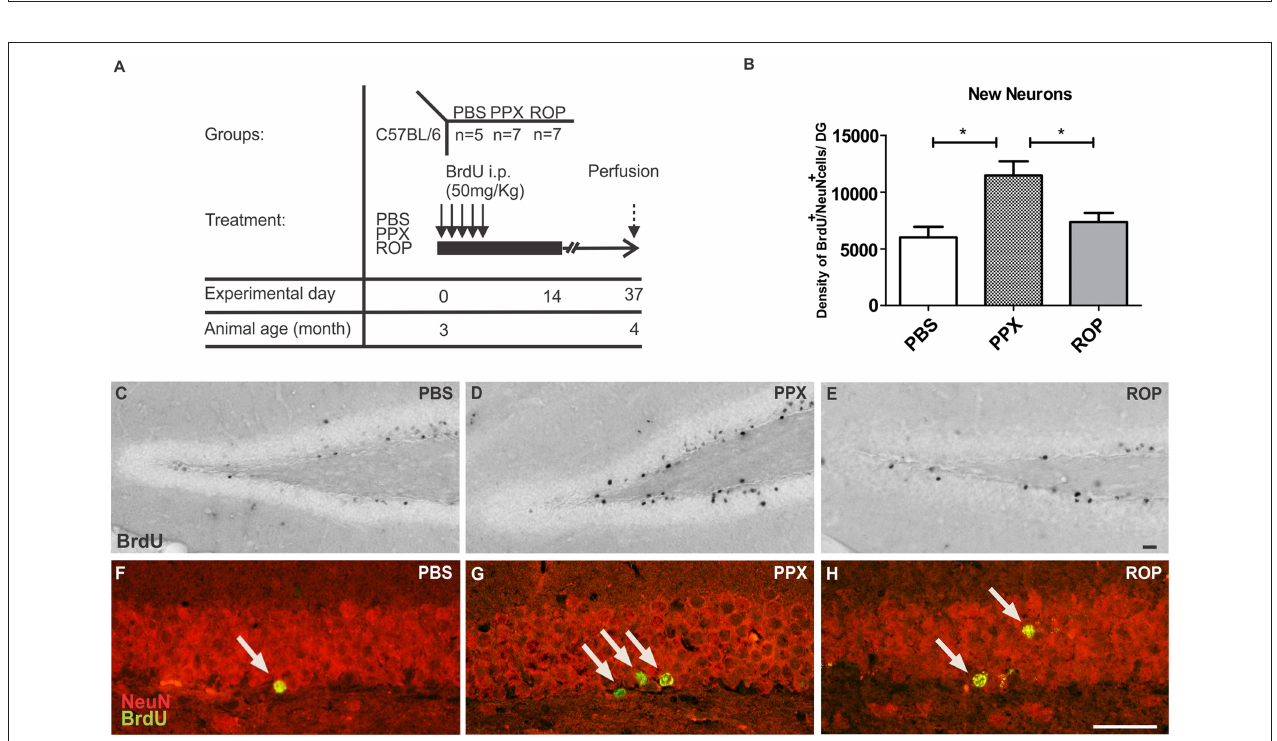
FIGURE 3 | PPX only increases the generation of new neurons in the murine DG. (A) Survival paradigm. At the beginning, 3-month-old animals received PPX, ROP or PBS i.p. for 14 days. During the first 5 days, all mice were i.p. injected with BrdU (50mg/kg). Animals were perfused 32 days after the last BrdU injection. (B) Hippocampal neurogenesis (calculated density of BrdU + /NeuN + neurons) was increased after PPX compared to PBS. No change in DG neurogenesis was observed after ROP treatment. Representative stainings of BrdU + in the DG of the hippocampus of PBS (C) , PPX (D) , and ROP (E) treated mice show a significant increase in PPX-injected animals compared to ROP- and PBS-injected controls. Confocal microscopy depicts double-labeled BrdU + (green)/NeuN + (red) neurons in the hippocampal DG of PBS (F) , PPX (G) , and ROP-injected mice (H) . Error bars represent mean ± SEM. One-way ANOVA followed by Tukey’s post-hoc test, * p < 0.05. Scale bars: 20 µ m (C–H) .